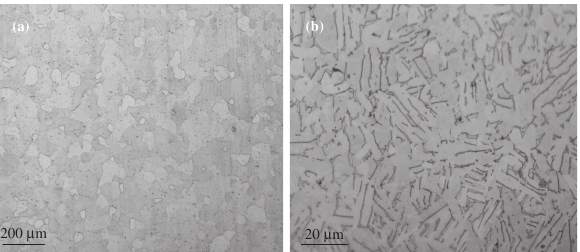
Figure 1: Optical microstructure of Ti-5Al-2.5Sn (a) and Ti-6Al-4V (b) alloys. (a) single α phase; (b) dark ¼ β phase, light matrix ¼ α phase.